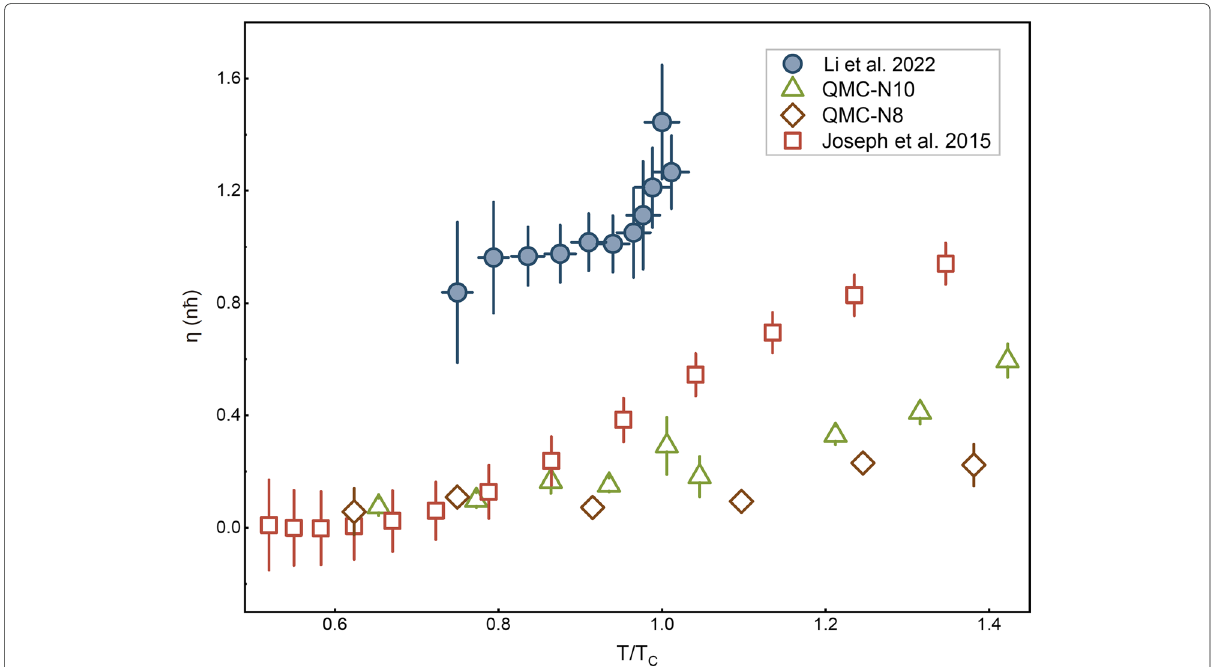
Fig. 21 The shear viscosity of a unitary Fermi gas measured at NCSU in 2015 (empty squares) [28] and at USTC group in 2022 (solid circles) [33], as a function of the reduced temperature T / T c . For comparison, we show also the quantum Monte Carlo simulations with lattice size N = 8 3 (empty diamonds) and N = 10 3 (empty triangles) [78]. From Ref.